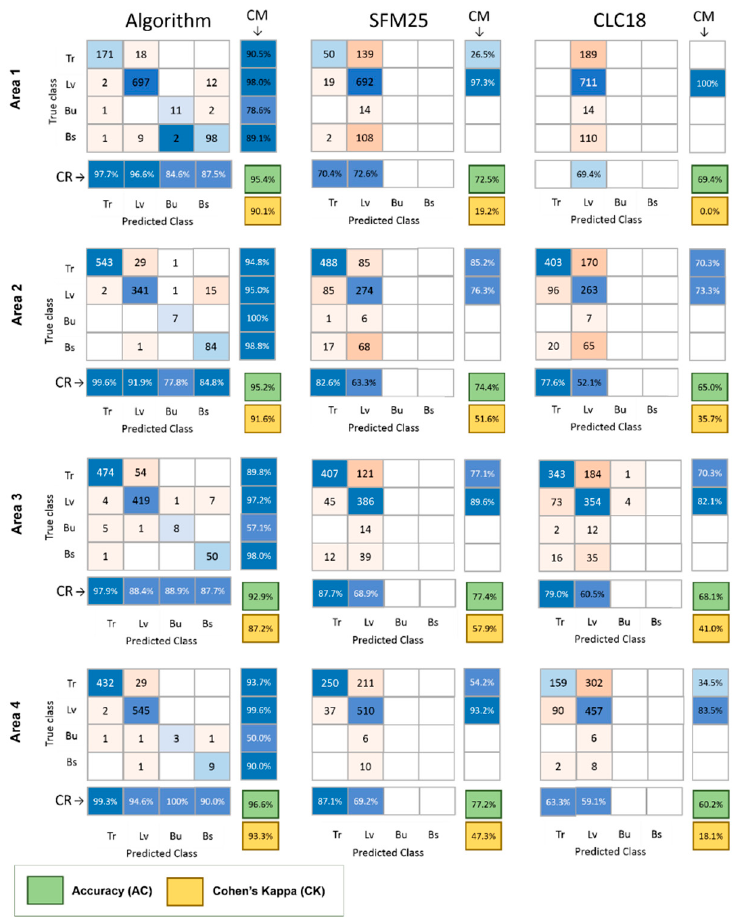
Figure 4. Confusion matrix, accuracy (AC), Cohen’s kappa coefficient (CK), completeness (CM), and correctness (CR) obtained with the proposed algorithm. True classes were determined by visual inspection and from SFM25 and CLC18 maps. Abbreviations: Tr: forest and trees, Lv: shrublands and low vegetation, Bs: bare soil, Bu: buildings. Validation metrics: CM: completeness. CR: correctness.